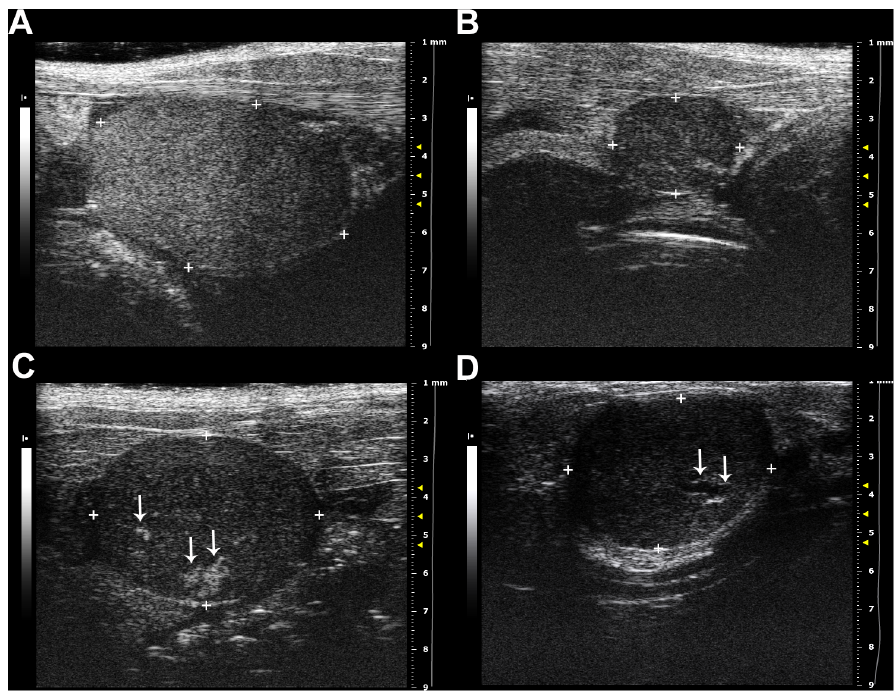
Fig 2. Ultrasonographic appearance of Fukomys anselli testicles. Testicles of breeders (A) compared to non-breeders (B) were significantly larger. Irregular hyperechoic lesions were found in 10 out of 13 individuals (C); additionally cystic alterations were present in two out of 13 individuals (D).